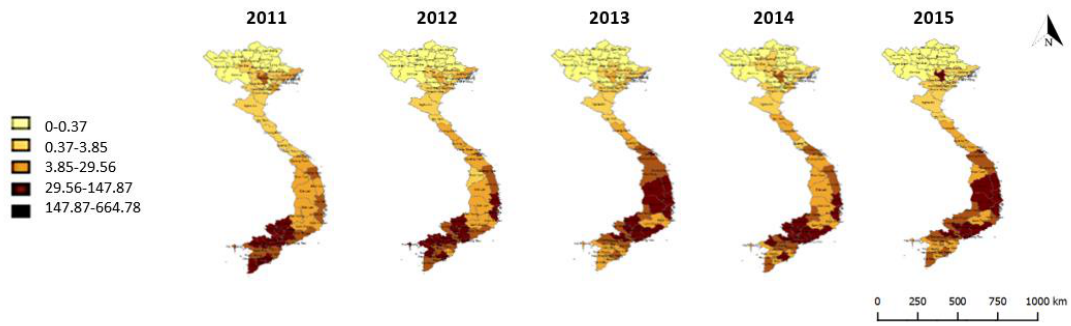
Figure 2. Map of observed dengue cases per 100,000 population, provincial rates, 2011–2015. Table 1. Summary statistics, dengue rates (counts per 100,000 population by province-year), 2011– 2015.